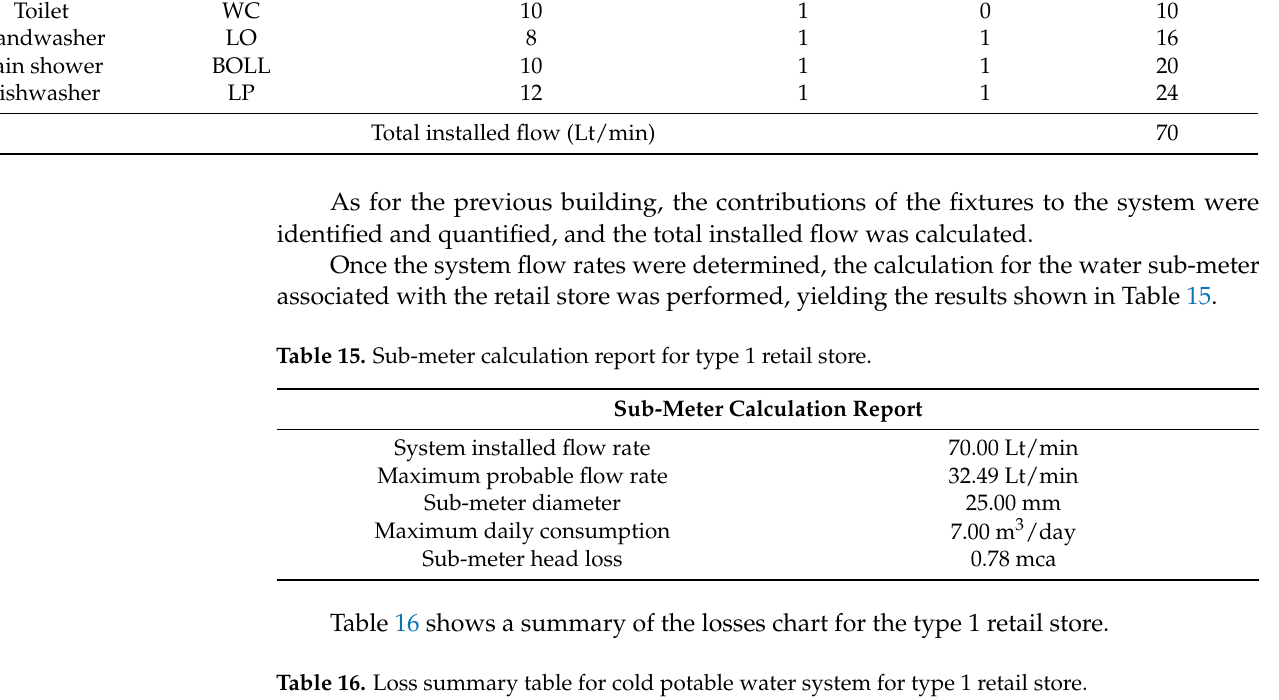
Table 16. Loss summary table for cold potable water system for type 1 retail